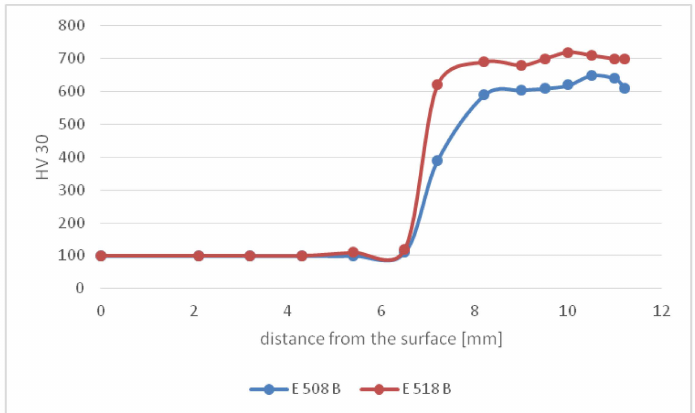
Figure 2. Course of hardness in three-layer hard-faced